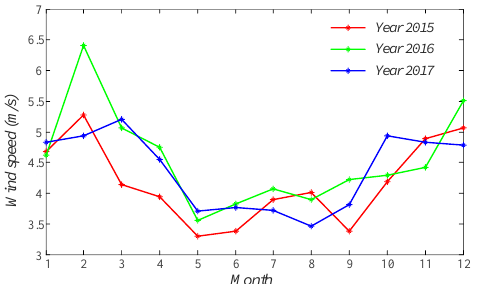
Figure 1. The monthly averaged wind speed of datasets in years 2015 – 2017.